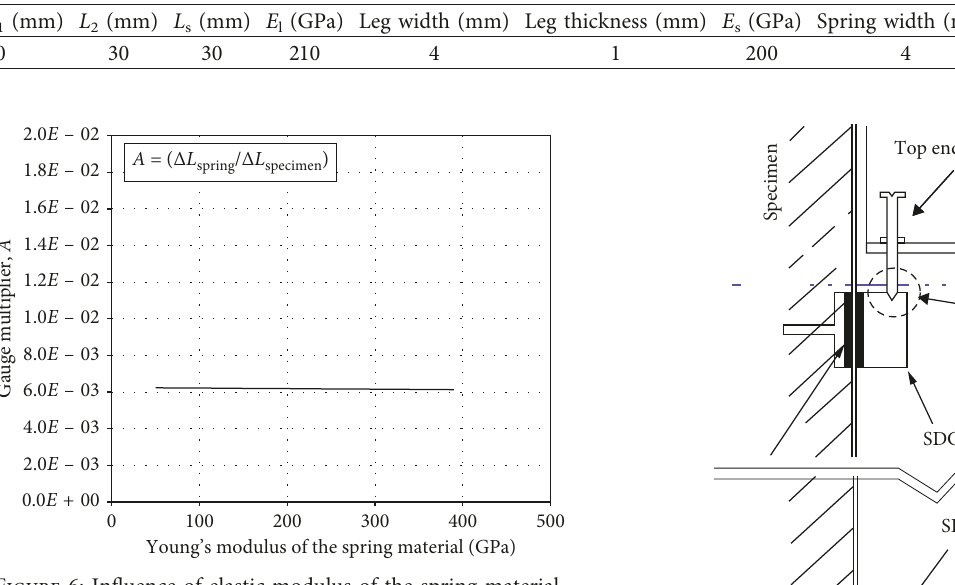
Table 2: Default values used to produce the relationships in Figure 4.